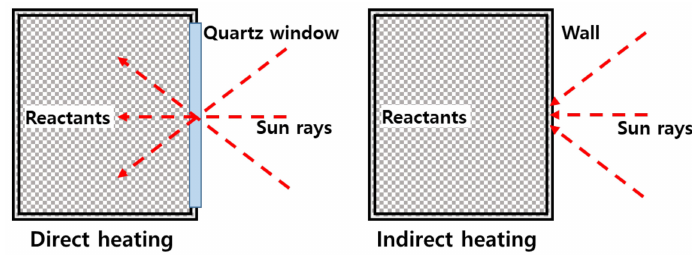
Figure 1. Direct and indirect heating